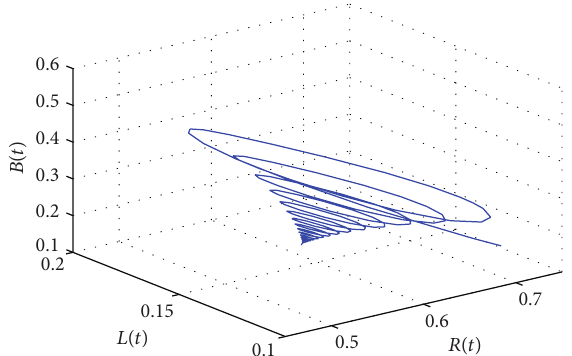
Figure 2: The phase plot of states 𝐿 , 𝐵 , and 𝑅 for 𝜏 = 55.2386 < 𝜏 0 = 58.5472